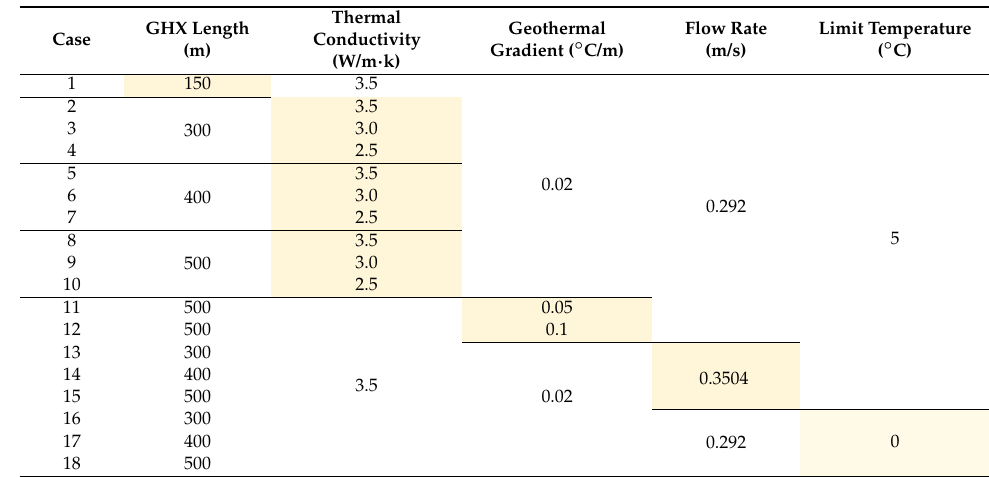
Table 2. Case study conditions.